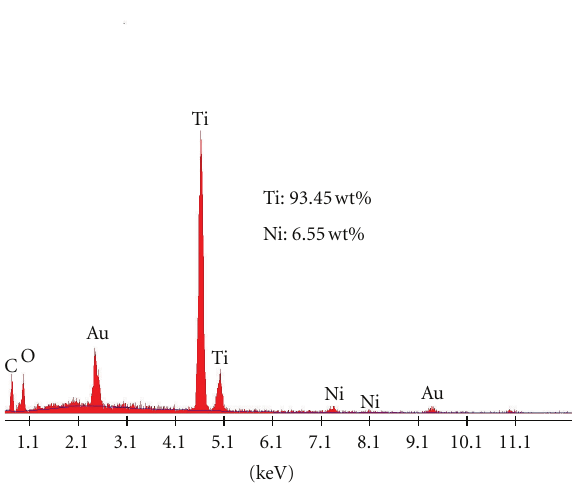
Figure 4: EDAX spectra of 5 at. wt.% Ni-doped TiO 2 powder formed at 550 ◦ C for 6h.